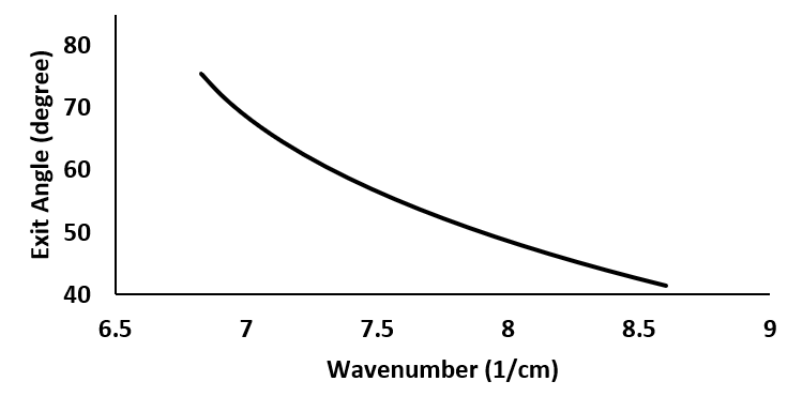
Figure 1. Exit angle of the light from the grating vs.